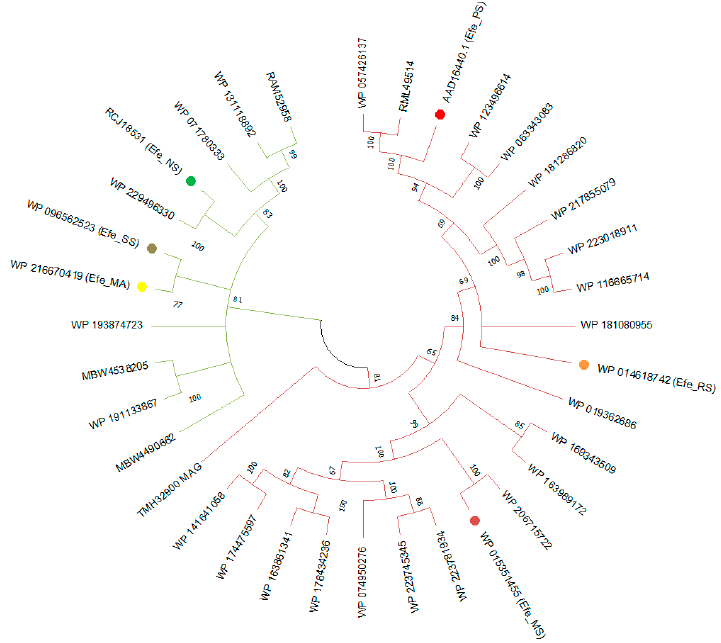
Figure 2. ML ‐ Boostrap ‐ phylogenetic tree of Efe ‐ homologous sequences. The green branches of the Figure 2. ML-Boostrap-phylogenetic tree of Efe-homologous sequences. The green branches of the tree indicate cyanobacteria and rose ‐ red proteobacteria. The sequences used in the next step are tree indicate cyanobacteria and rose-red proteobacteria. The sequences used in the next step are marked with dots of relevant different colours. marked with dots of relevant different